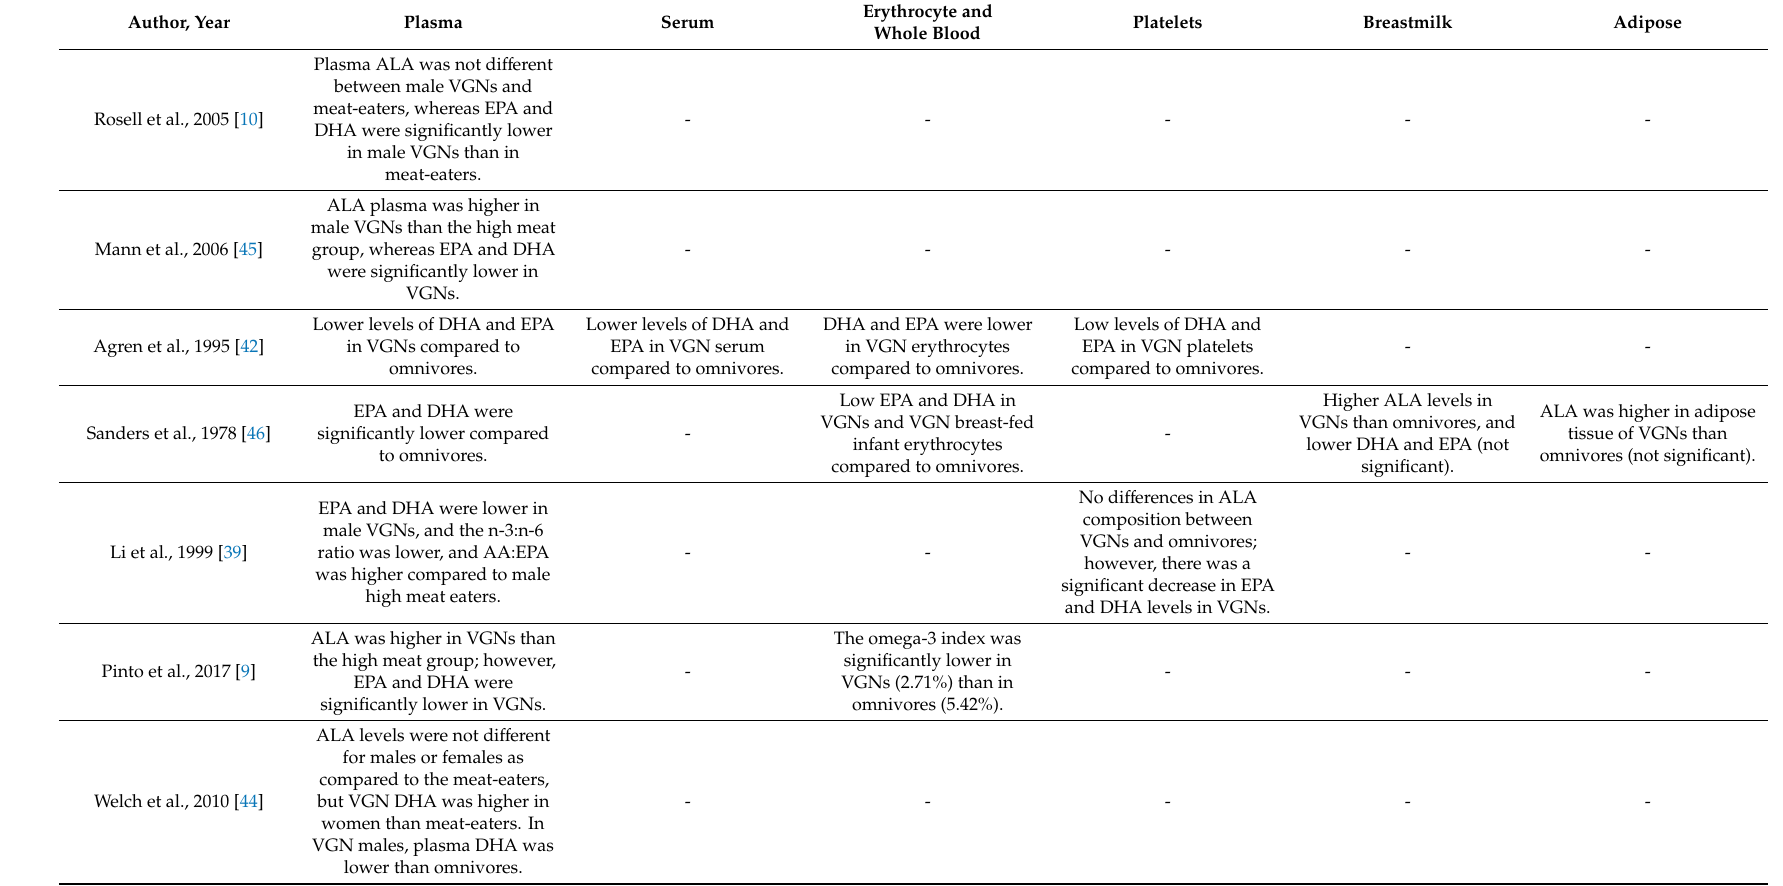
Table 3. Concentrations of n-3 fatty acids in various tissues by following a vegan or non-vegan diet (as cited in